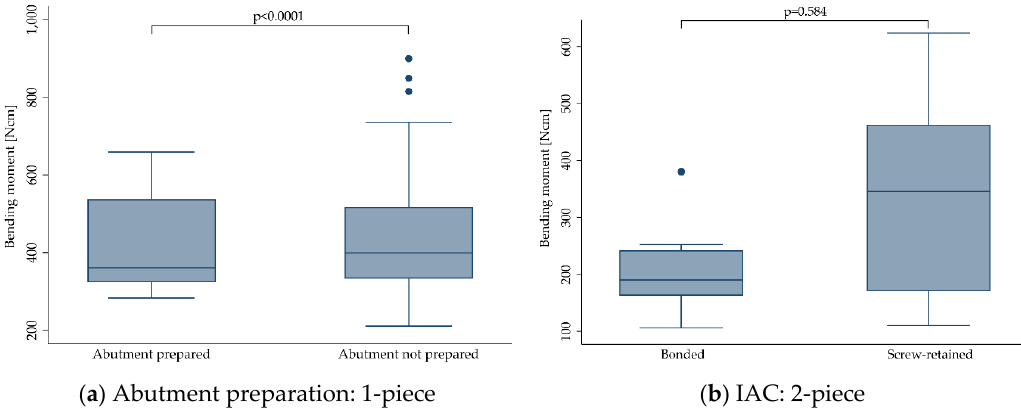
Figure 7. Boxplots showing the bending moment at the time point of fracture depending on the abutment preparation for 1-piece ( a ) and depending on the implant-abutment-connection (IAC) for 2-piece ( b ) zirconia implants. Whiskers are used to represent all samples lying within 1.5 times the interquartile range. Dots represent outliers. Detailed data can be found in Tables 3 and 4.